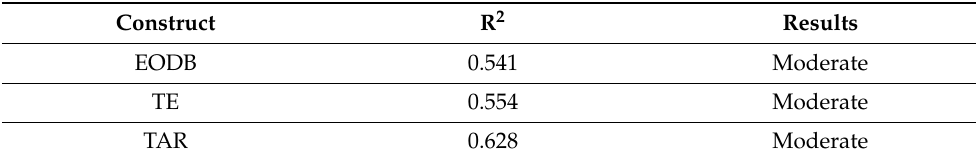
Table 8. R 2 of the endogenous latent